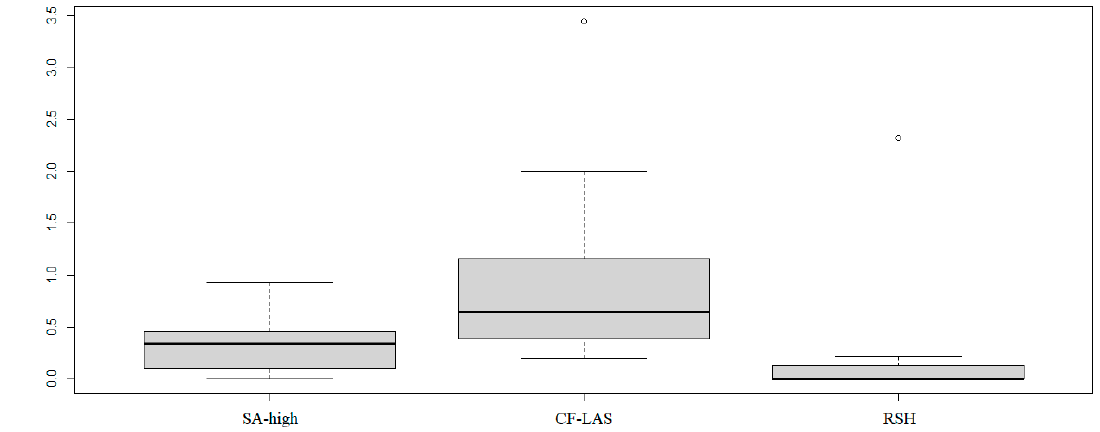
Figure 10. Box-and-whisker plot to evaluate homoscedasticity between the compared algorithms. The Welch and Box test [58] was performed in order to perform statistical analysis with robust ANOVA using the WRS R package [59] to compare the three algorithms using the 10% of the trimmed means. The obtained p -value was 1.912572 × 10 − 5 , and the null hypothesis was refuted. The value F w of the statistician was 18.31316, and the degrees of freedom were v 1 = 2 and v 2 = 22.47213.